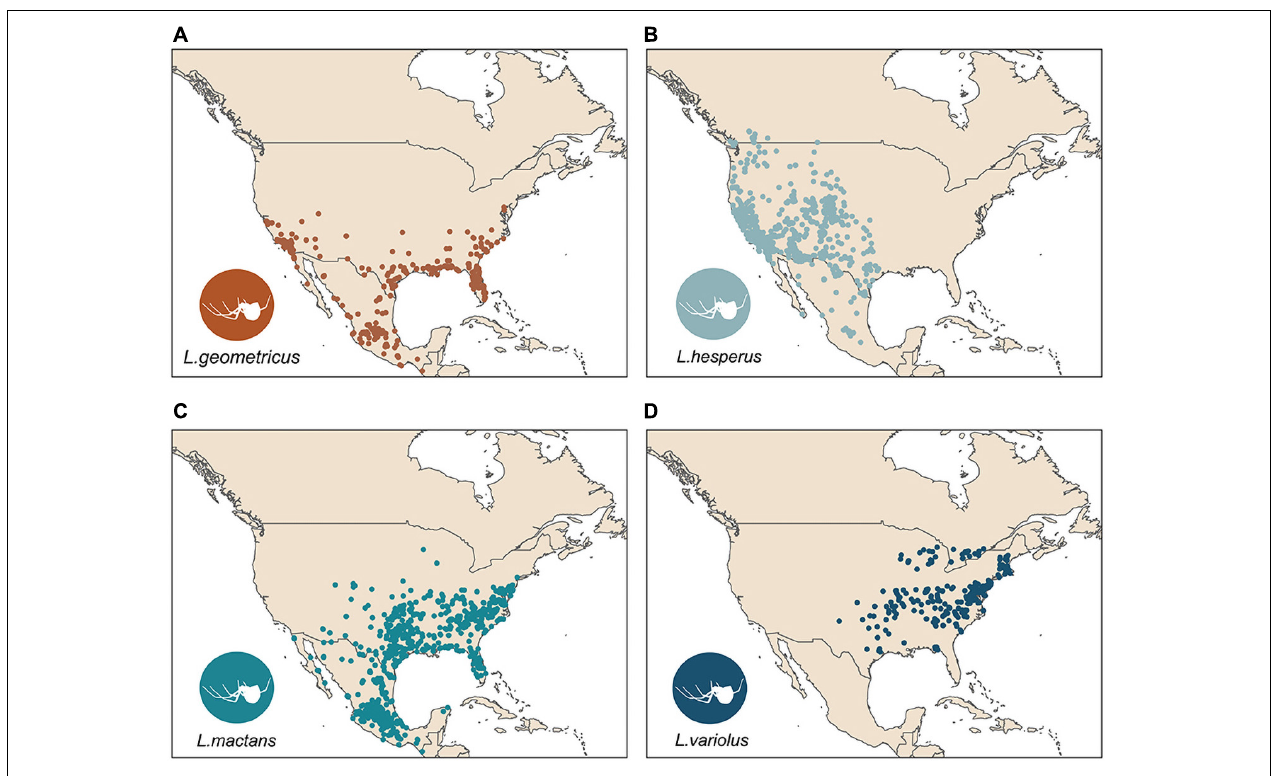
FIGURE 1 | Subsampled occurrence points in North America used for SDMs for L. geometricus (A) , L. hesperus (B) , L. mactans (C) , L. variolus (D) .